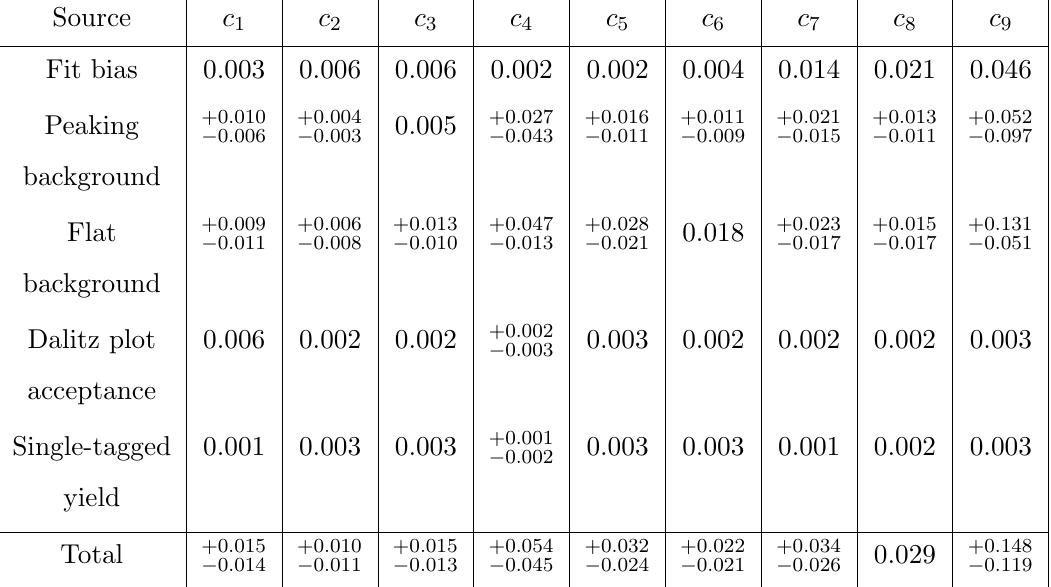
Table 7 . Systematic uncertainties on c i